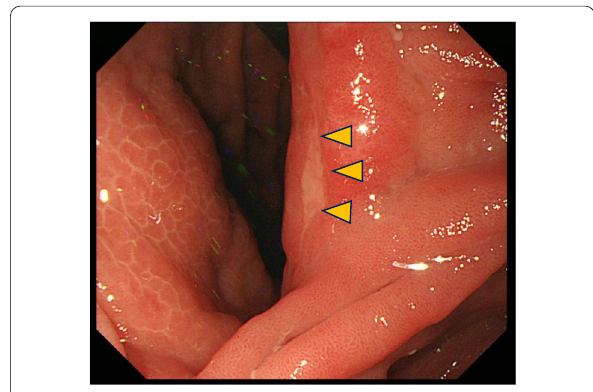
Fig. 2 Endoscopic findings of the gastrojejunal anastomosis. Endoscopic examination revealed 0–IIc. A biopsy specimen obtained from the tumor shows signet-ring cell carcinoma (SRCC)